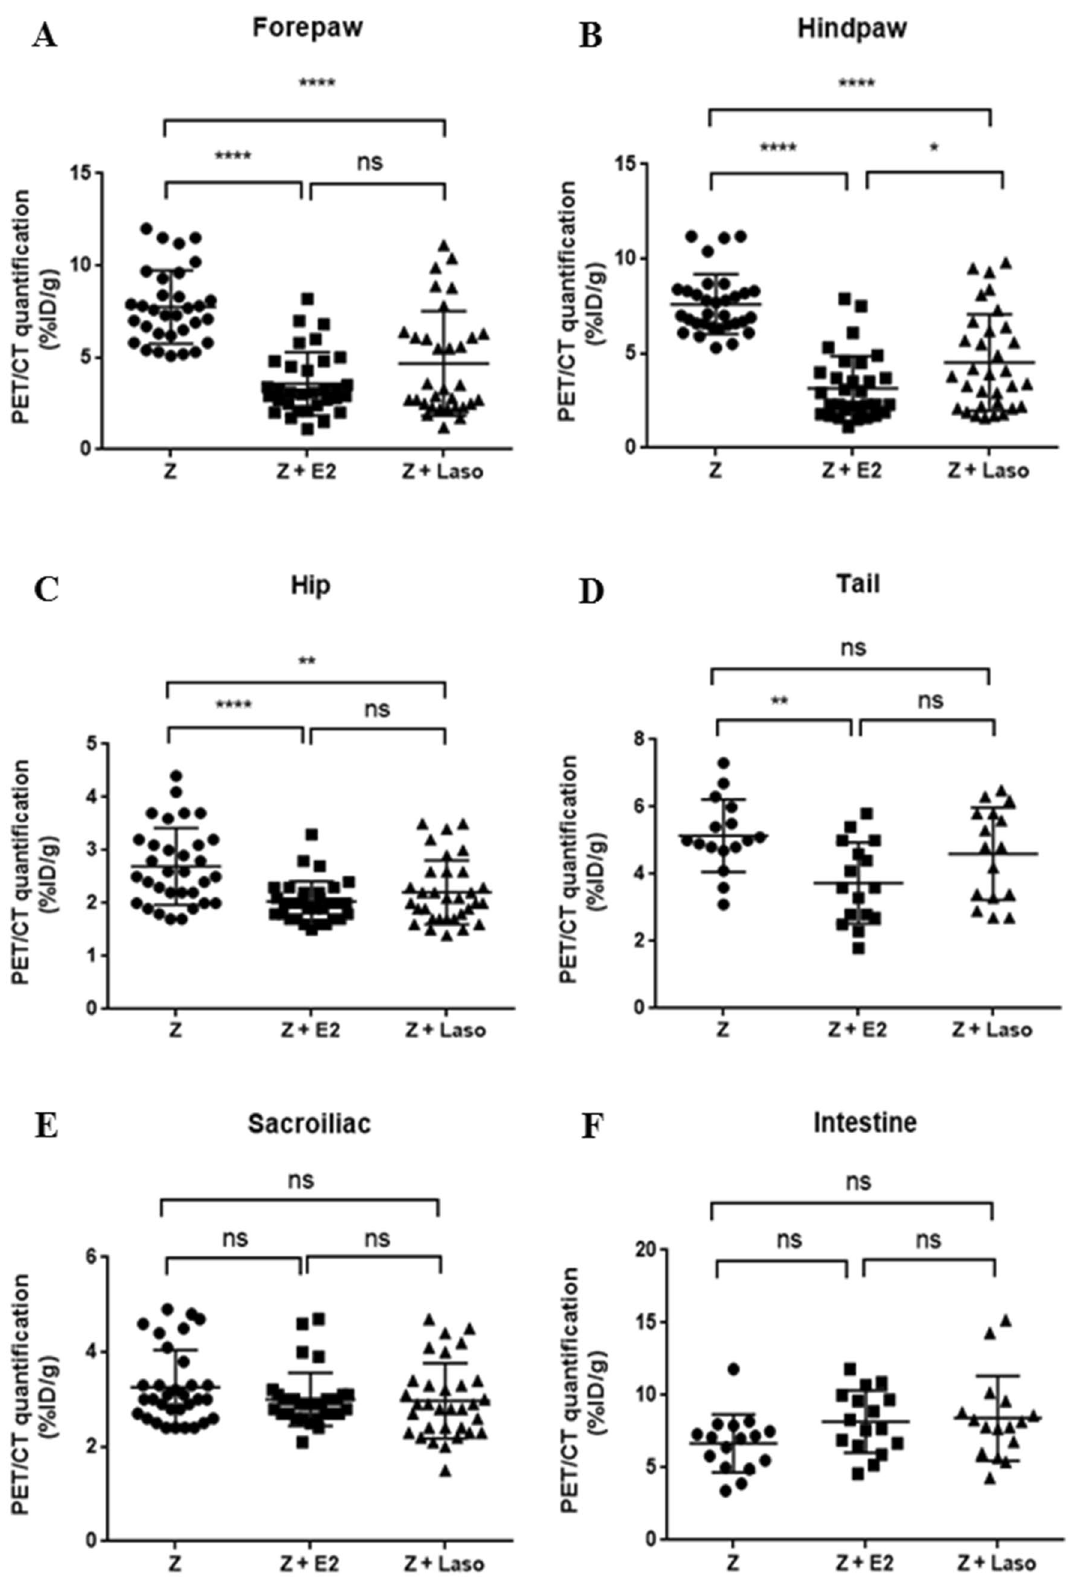
Figure 2. Measurement of 18 F-fluorodeoxyglucose uptake. A Quantification of regions of interest in forepaw of 6 weeks after zymosan (Z) injection, Z + 17β-estradiol (E2) treated mice, and Z + lasofoxifene (Laso) treated mice. B-F Hindpaw ( B ), hip ( C ), tail ( D ), sacroiliac joint ( E ), and intestine ( F ). Values are mean ± standard error of the mean ( n = 16 mice per group). Analyses were performed using GraphPad Prism (version 5.0; GraphPad Software Inc., La Jolla, CA, USA, https:// graph pad- prism. softw are. infor mer. com/5. 0/). * p < 0.05, ** p < 0.01, *** p < 0.001, **** p < 0.0001. PET/CT positron emission tomography/computed